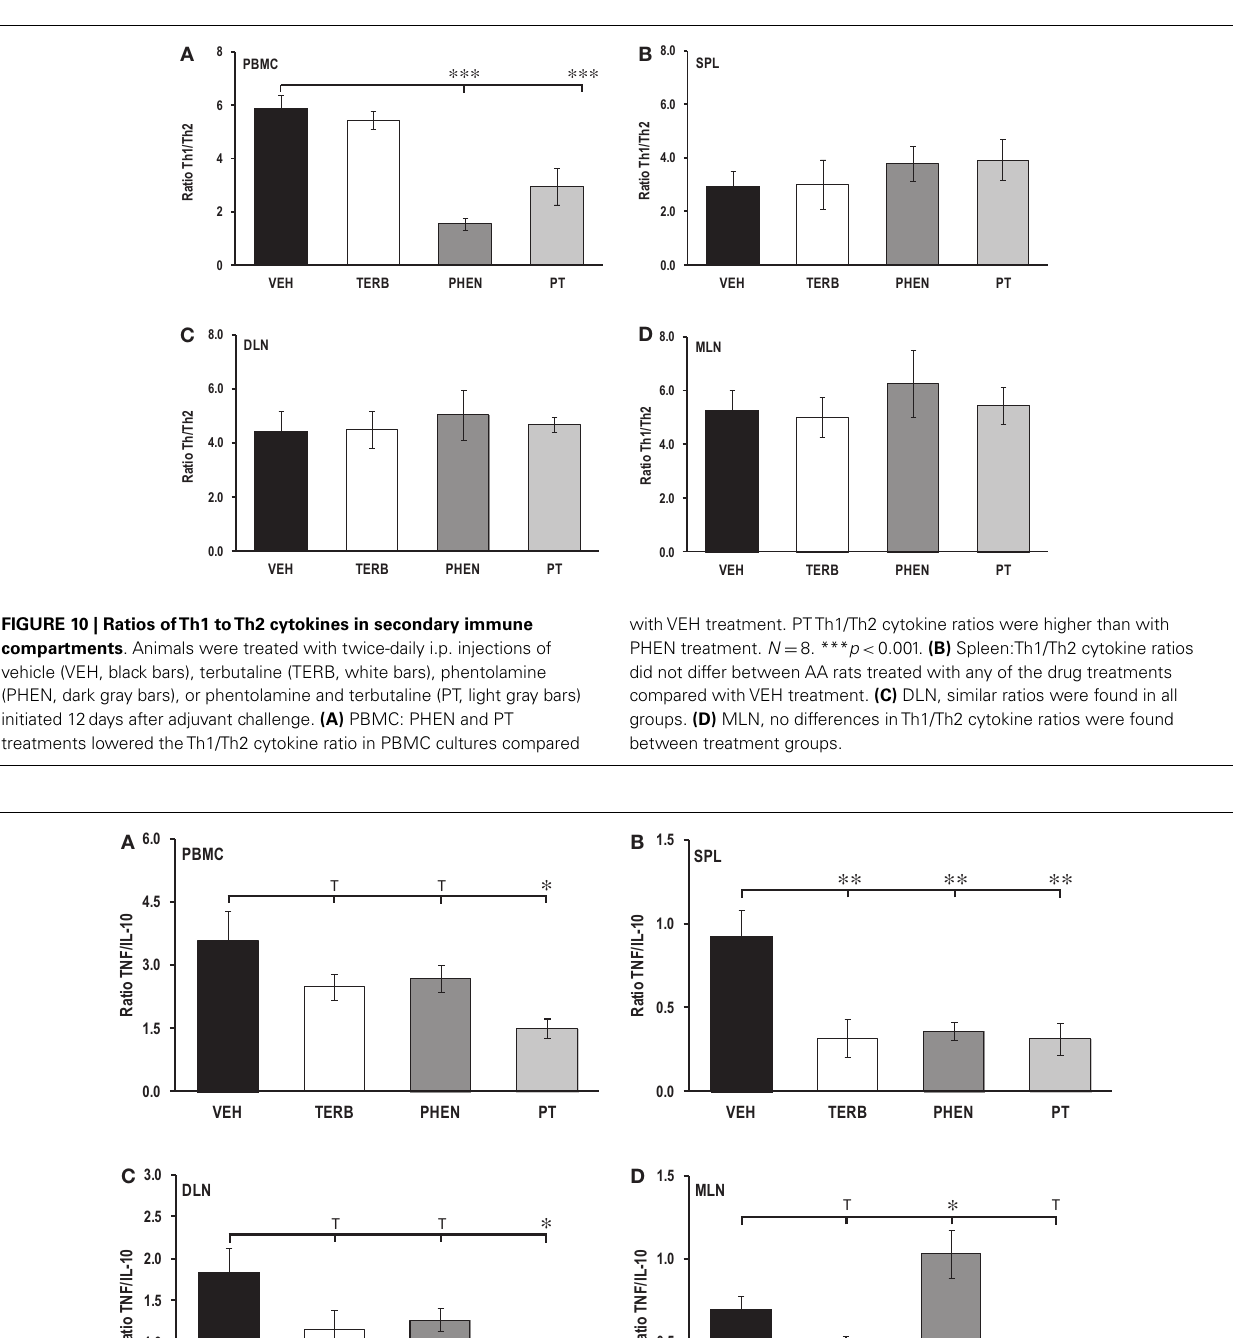
PBMC cultures compared withVEH treatment. N = 8. * p < 0.05. (B) Spleen: all drug treatments lowered theTNF/IL-10 ratio compared withVEH treatment. N = 8. ** p < 0.01. (C) DLN, PT suppressed theTNF/IL-10 ratio compared with VEH controls. N = 8. * p < 0.05. (D) MLN, theTNF/IL-10 ratio was greater in rats treated with PHEN than inVEH controls. N = 8. * p <